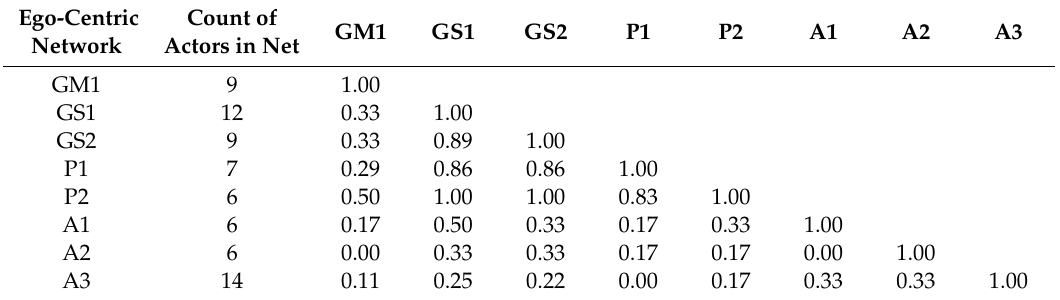
Table 1. Overlap between observed ego-centric networks: Szymkiewicz–Simpson’s overlap coe ffi cient. Ego-Centric